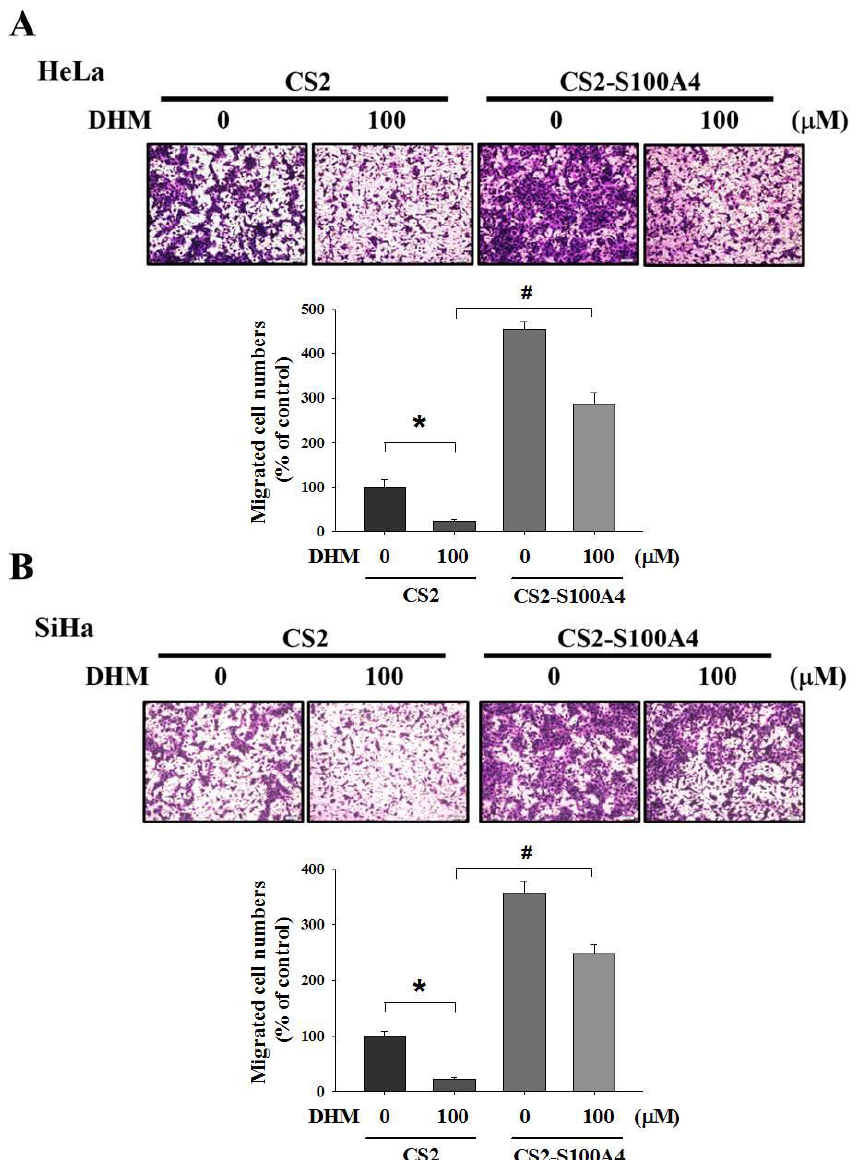
Figure 4. S100A4 overexpression and co-treatment with DHM in cervical cancer cell lines . ( A , B ) HeLa and SiHa cells were seeded onto 6 cm dish and transfected with CS2-vector or CS2-S100A4. After 24 h, we co- treatment with DHM (0, 100 μM) then analyzed by Boyden chamber assay (*, p < 0.05 compared with untreated; #, p < 0.05 compared with CS2-vector with DHM 100 μM). Cells were photographed using microscope